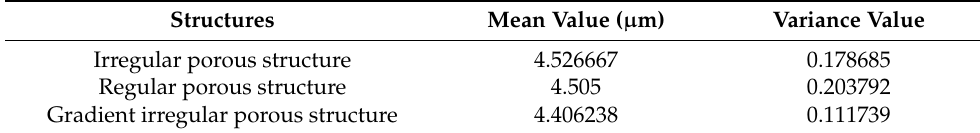
Table 6. The mean value and variance value of h.